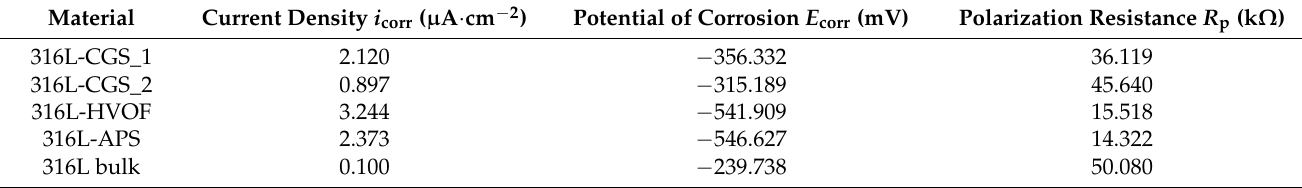
Table 5. Results of corrosion testing and abrasion rate for 316L CGS coatings and bulk.